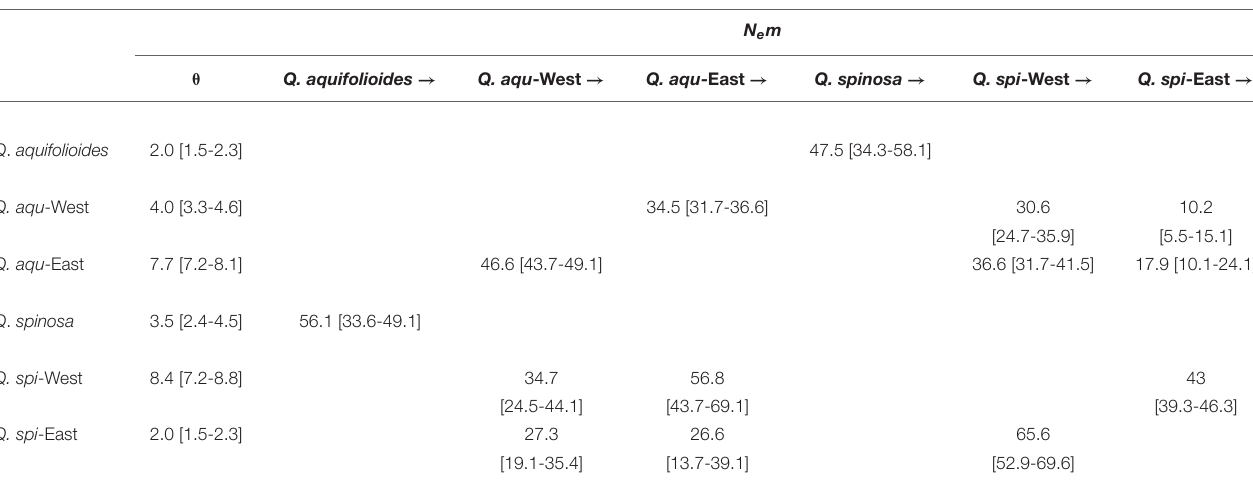
TABLE 3 | Historical gene flow as estimated by Migrate-n among Q. aquifolioides and Q. spinosa based on SSR